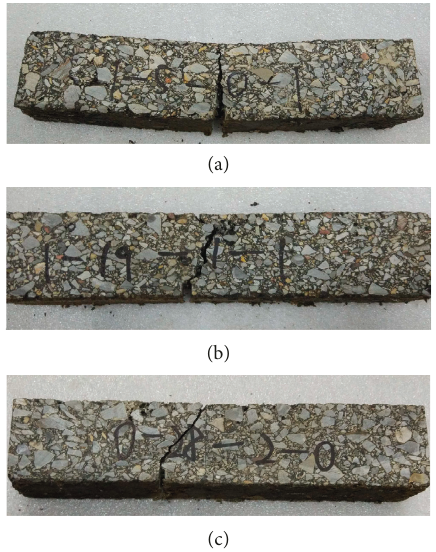
Figure 3: Crack propagation path. (a) Offset 0mm. (b) Offset 20mm. (c) Offset 40